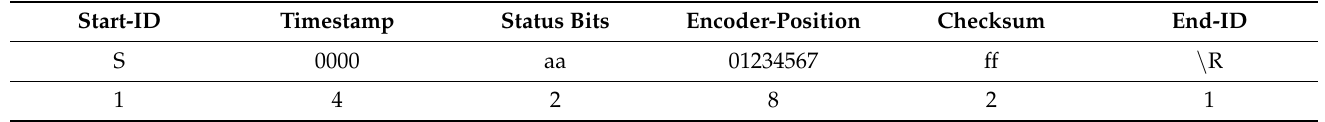
Table 3. Reduced telegram (18 bytes). Depicted are a dummy message and the number of bytes per datapoint.